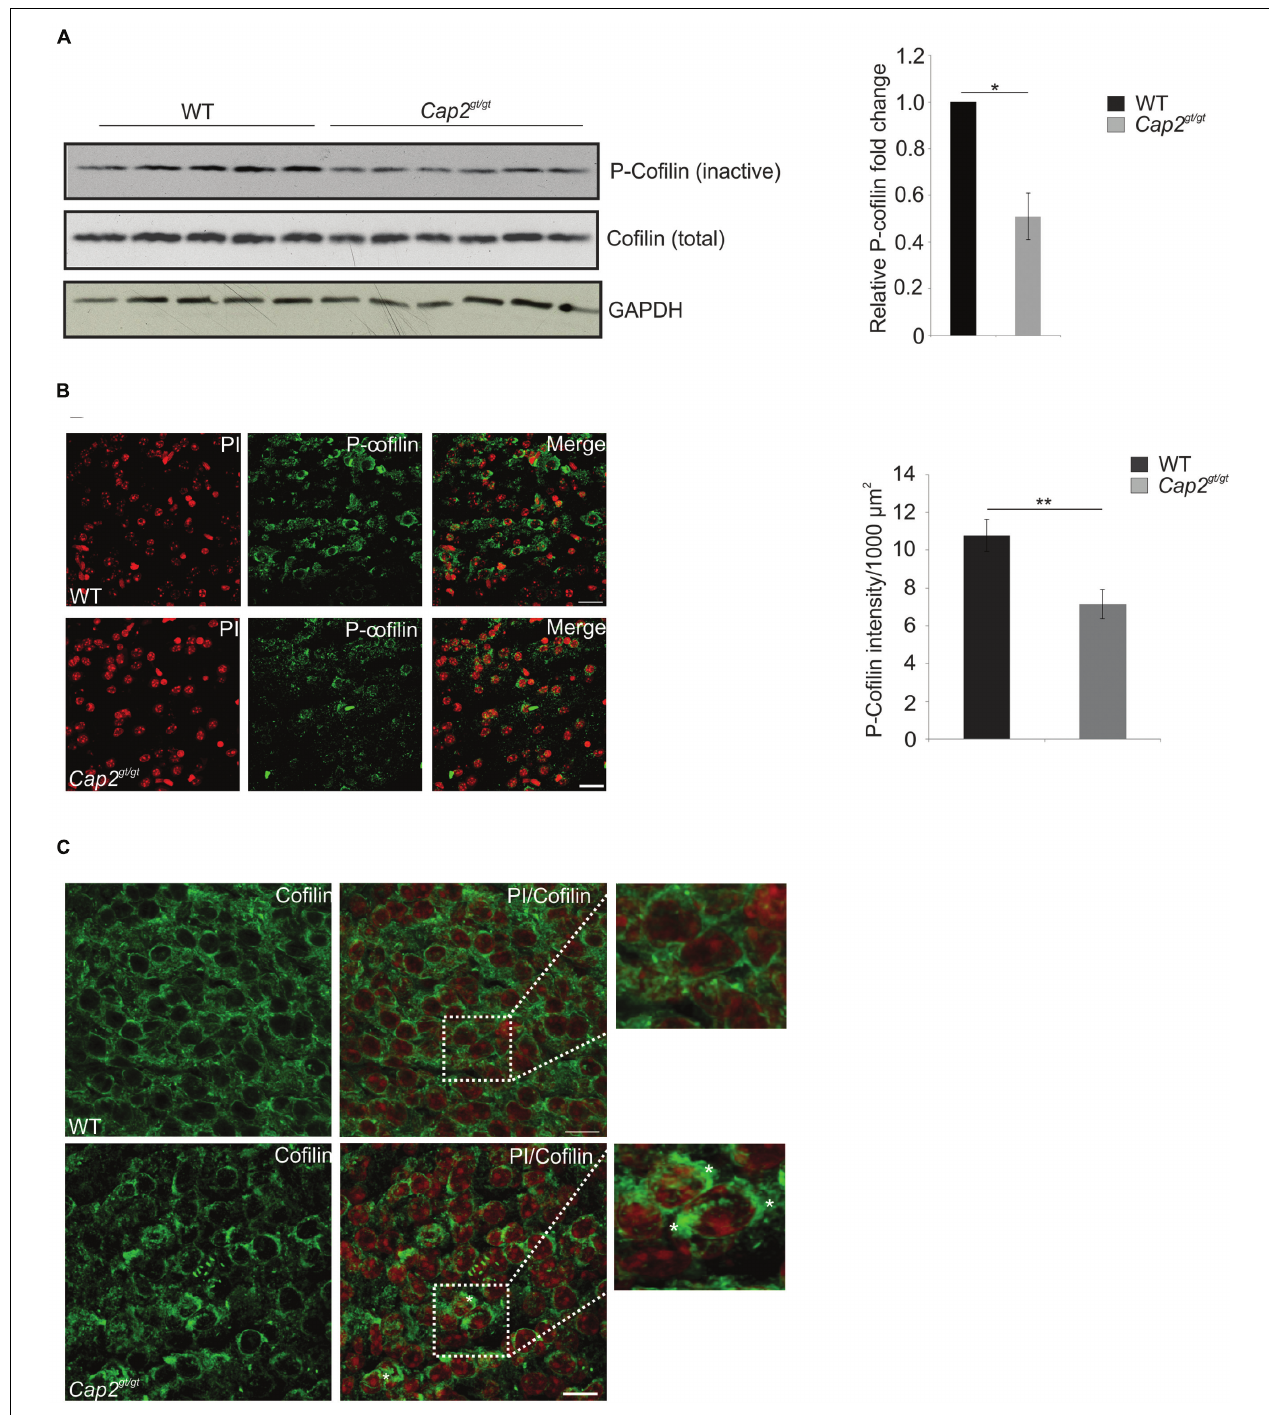
FIGURE 9 | CAP2 depletion increases cofilin dephosphorylation and its accumulation. (A) Western blotting of phospho Ser3 cofilin shows reduced cofilin phosphorylation in the CAP2 mutant cortical lysate. Total cofilin expression was unchanged in WT and mutant cortical lysate. GAPDH served as a loading control. Quantification of cofilin phosphorylation from six independent experiments analyzed using Student’s t -test (WT: 1; Cap2 gt / gt : 0.5 ± 0.1; n = 6, p < 0.05). Values were normalized to the loading control. (B) Immunohistochemical analysis of WT and CAP2 mutant brain section with rabbit monoclonal phospho cofilin antibody revealed a decrease in staining in the cortical region of mutant brain. Scale bar, 10 µ M. Quantification of phospho-cofilin revealed a significant difference in mutant brain (WT: 10.8 ± 0.8 P-n-cofilin intensity (AU)/1000 µ m 2 ; Cap2 gt / gt : 7.2 ± 0.8 P-n-cofilin intensity (AU)/1000 µ m 2 ; 2–4 sections per mice, total 4 mice, p < 0.01). (C) WT and Cap2 gt / gt brain sections were stained with rabbit monoclonal cofilin antibodies. Accumulation of cofilin in cytoplasmic aggregates was observed in CAP2 mutant brain as indicated by white asterisks, whereas cofilin was nicely distributed in the cytoplasm and nucleus of WT brain. Scale bar, 10 µ M. ∗ p < 0.05, ∗∗ p < 0.01.